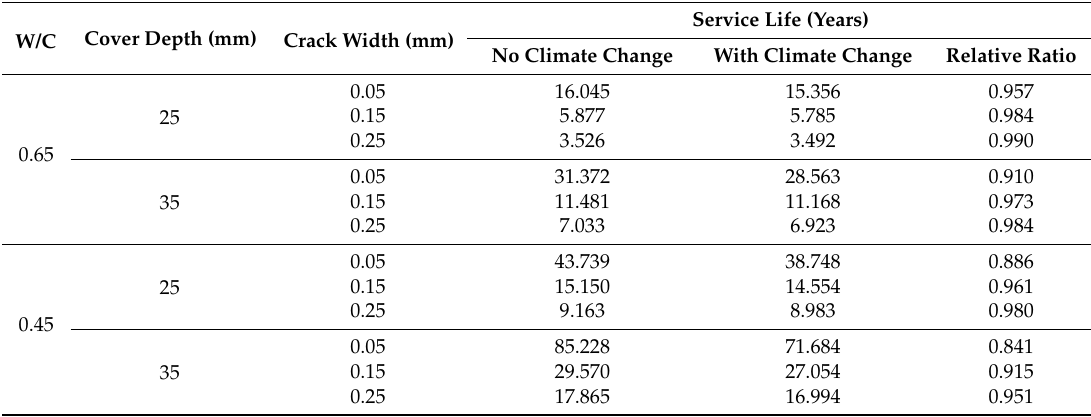
Table 6. Service life of cracked concrete-RCP 2.6, time slice 2000.